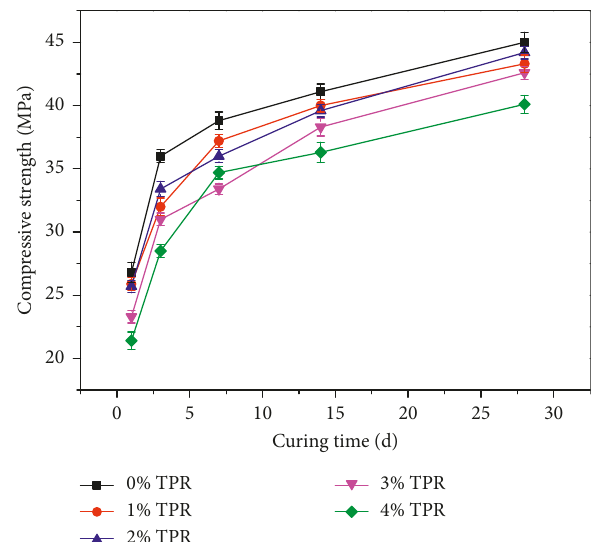
Figure 8: Compressive strength of cement stone with different TPR contents for different curing times.